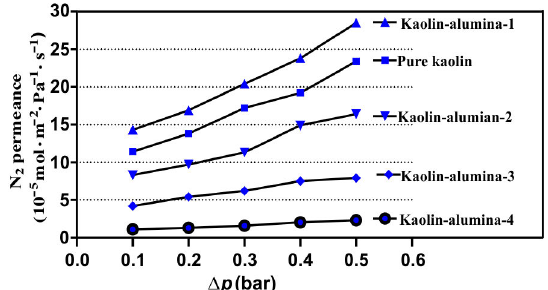
Fig. 6 N 2 permeance of the kaolin and kaolin/alumina ceramic